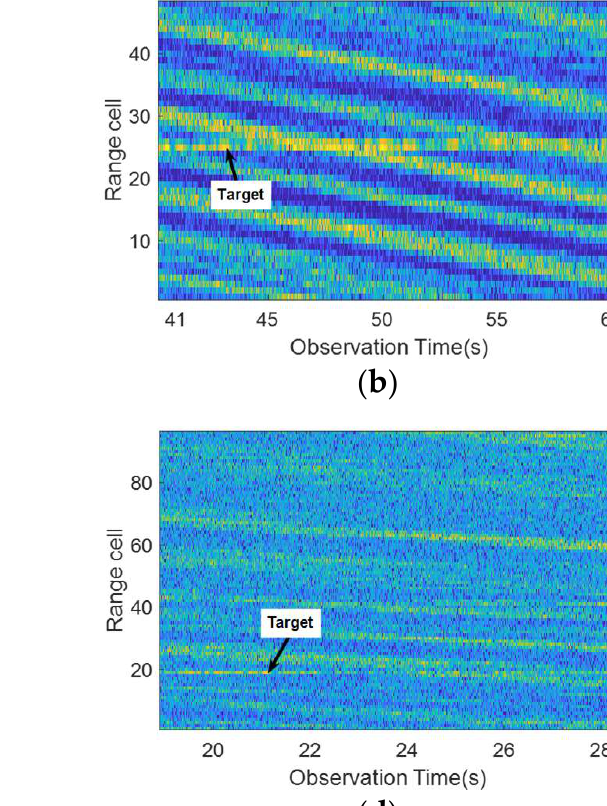
( c ) Figure 10. The detection results of different detection methods are visualized under different SCR sea state conditions. The detection result is obtained from the test samples. The radar observation target is the floating ball, the radar observation time is 0.512 s, and the false alarm probability is 3 10  . The detection results of data #IPIX_01, #IPIX_02, and #IPIX_03 are shown from top to bottom by the row. The yellow marker is the detected target location. ( a ) Proposed detector; ( b ) Feature-based detector using three TF features [19]; ( c ) Tri-feature-based detector [18]. 4.4. Performance Analysis of Different Marine Floating Targets